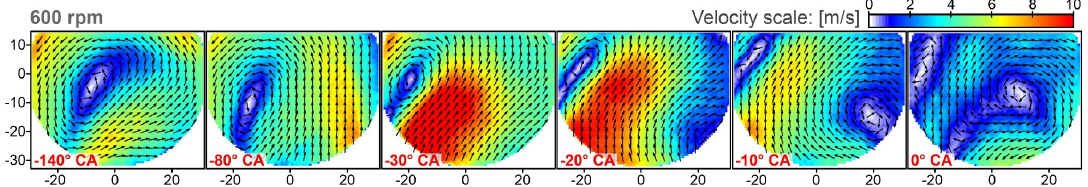
Figure 14. Ensemble averaged mean velocities (color: magnitude; arrows: flow direction) at selected crank angles in the compression stroke for the standard settings (600 rpm and peak compression pressure 100 bar).